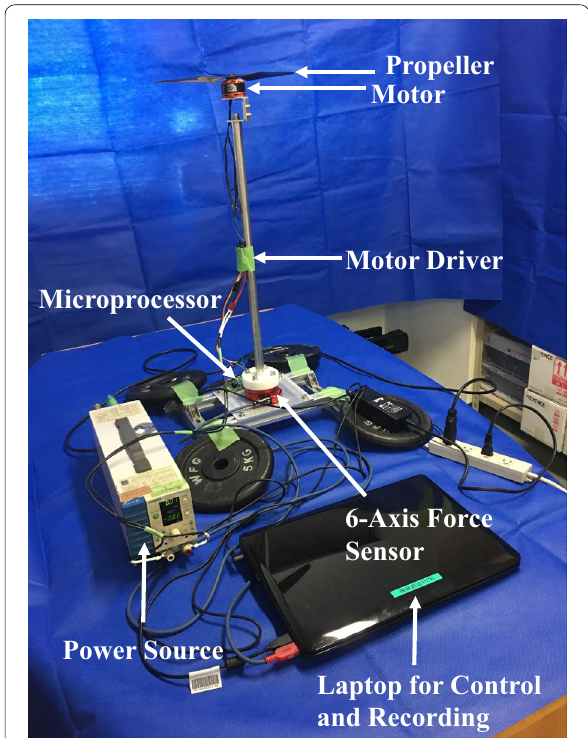
Fig. 5 A device for testing the thrusts and reaction torques of a flying watch